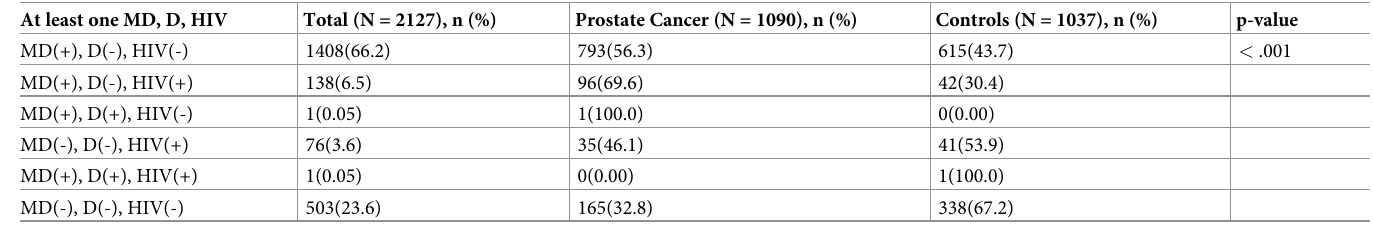
MD = Metabolic disease; D = depression and HIV = Human immunodeficiency